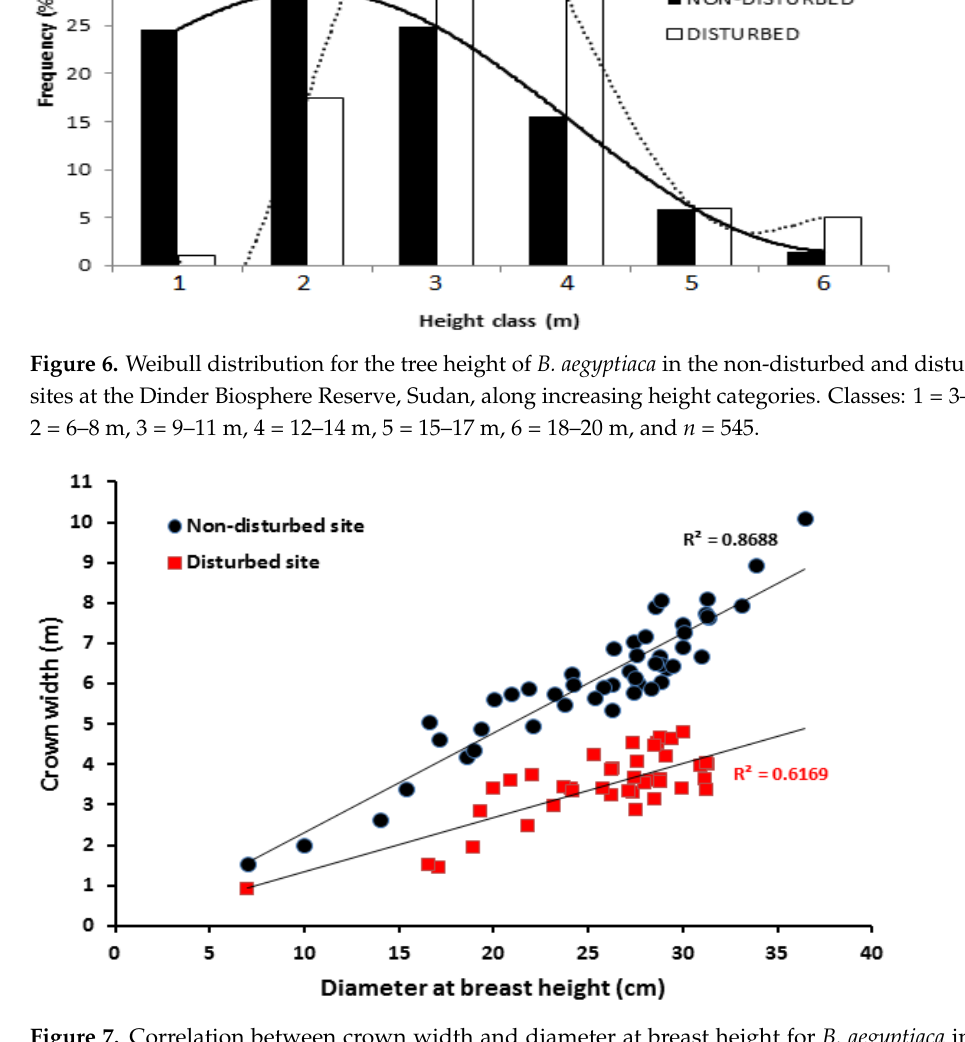
Figure 7. Correlation between crown width and diameter at breast height for B. aegyptiaca in the disturbed and non-disturbed sites at the Dinder Biosphere Reserve, n = 545.